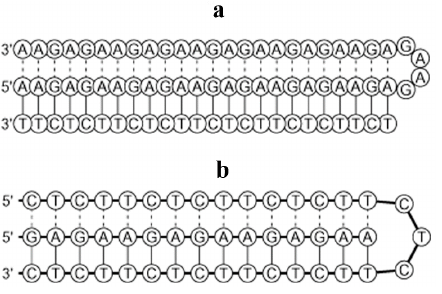
Figure 6. Conceptual intra-molecular triple helices formed by AAGAG tandem repeats. 2D